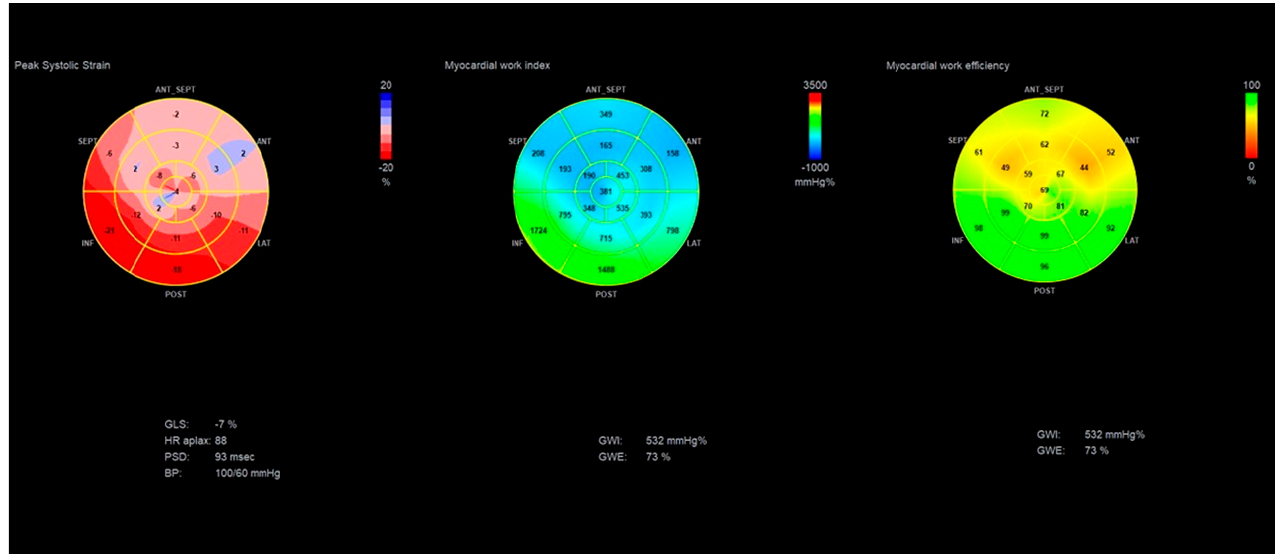
Figure 4. Bull’s eye of GLS, GWI, and GWE showing global and segmental values in a normal heart. GLS = − 20%, GWI = 1969 mmHg%, and GWE = 96%.